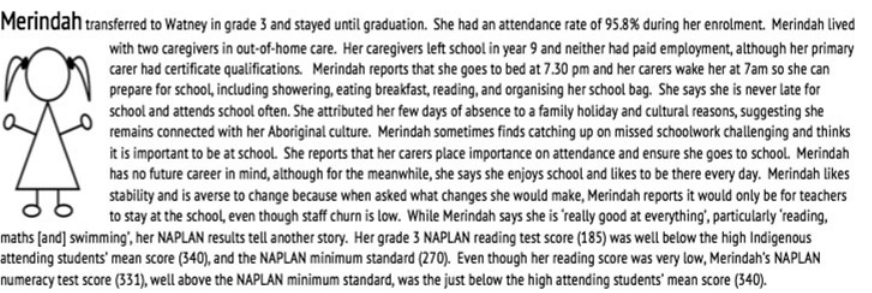
Fig. 2. Profile of Merindah (pseudonym) that provides a holistic depiction of a high-attending student at Watney using data collected from the school ’ s admin- istrative records and questionnaire